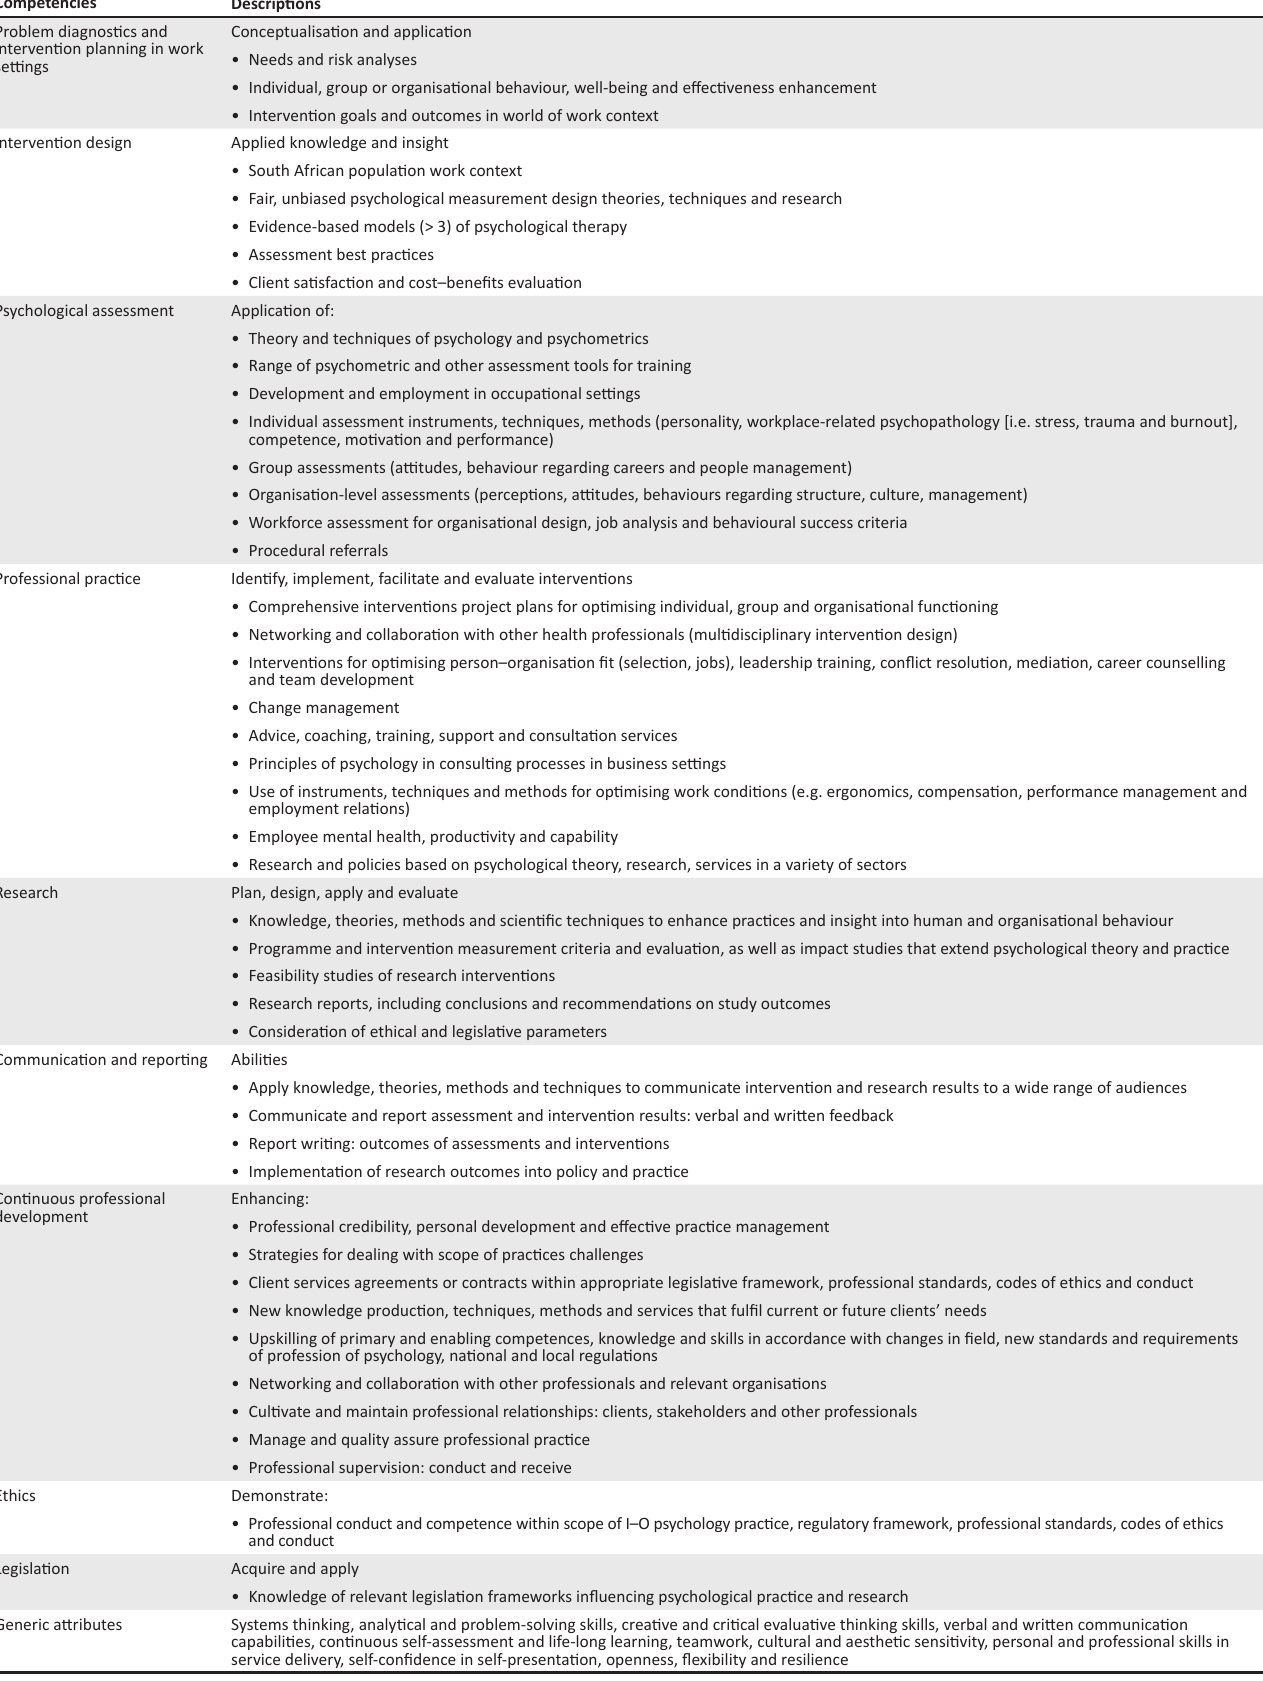
TABLE 1: Minimum competencies for industrial